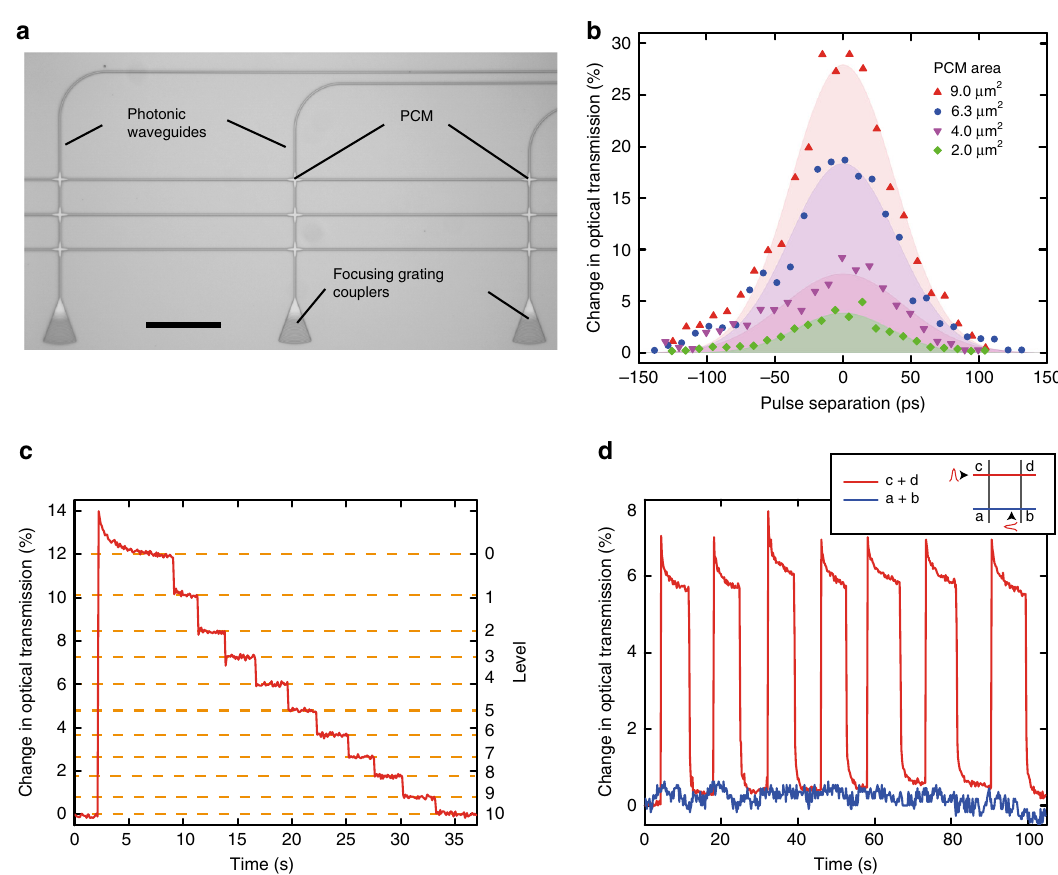
Fig. 4 Two-pulse switching of waveguide crossings. a Optical micrograph of a studied crossed-waveguide photonic array (Scale bar is 100 µ m). b Measured change in optical device transmission upon amorphization for different relative arrival times of the two 1 ps pulses. Since the pulse powers are chosen low enough, separate excitations (delay more than 150 ps) cannot trigger a transition. Only simultaneously arriving pulses at the PCM-cell induce a phase-change. c Multilevel operation of a single crossing shows that also the arithmetic operations presented in Fig. 2 can be executed with the two-pulse switching scheme. d Transmission across cells ‘ c ’ and ‘ d ’ (red) and ‘ a ’ and ‘ b ’ (blue) during repeated switching of cell ‘ d ’ via pulses sent along ‘ cd ’ and ‘ bd ’ (cf. inset). The shown transmission through the ʻ a ’ and ‘ b ’ cells is unaffected by the switching, which demonstrates that only the selected cell ‘ d ’